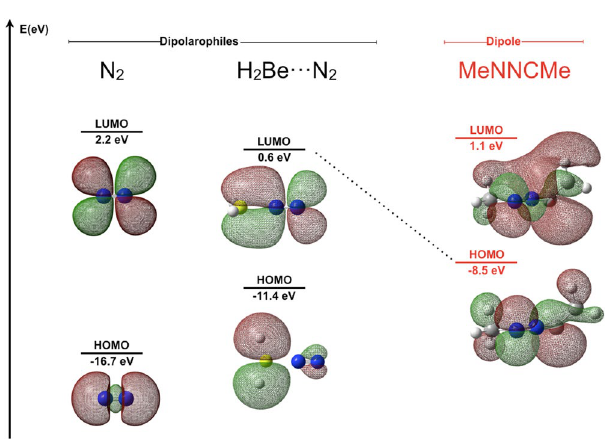
Figure 5. HOMO-LUMO gaps for the different neutral dipolarophiles (N 2 , FH···N 2 , HLi···N 2 , H 2 Be···N 2 , H